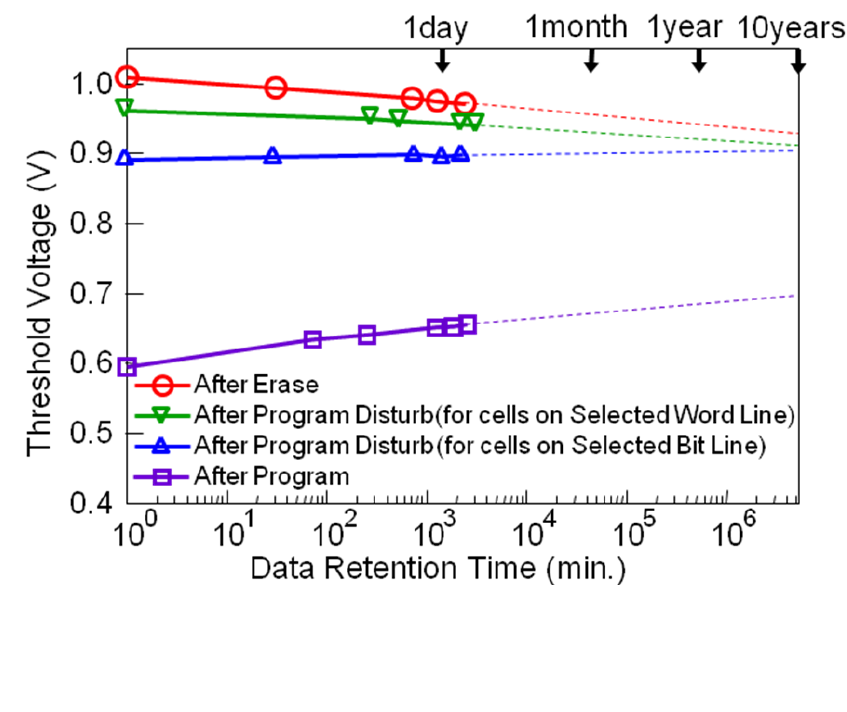
Figure 12. Data retention after the program, erase, V Reproduced from [41] with permission of